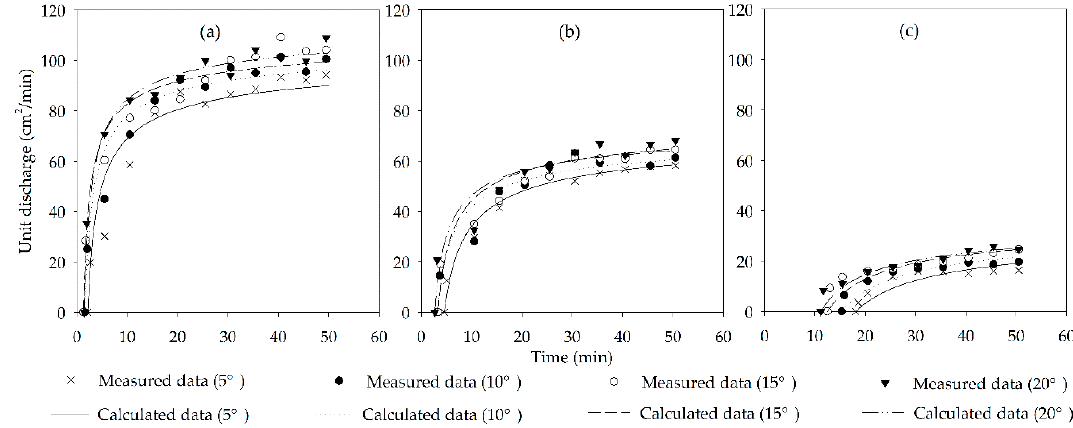
Figure 4. Comparison of the calculated and measured unit discharge of runoff under different slope gradients and different rainfall intensities: ( a ) 75 mm/h, ( b ) 50 mm/h, ( c ) 25 mm/h.